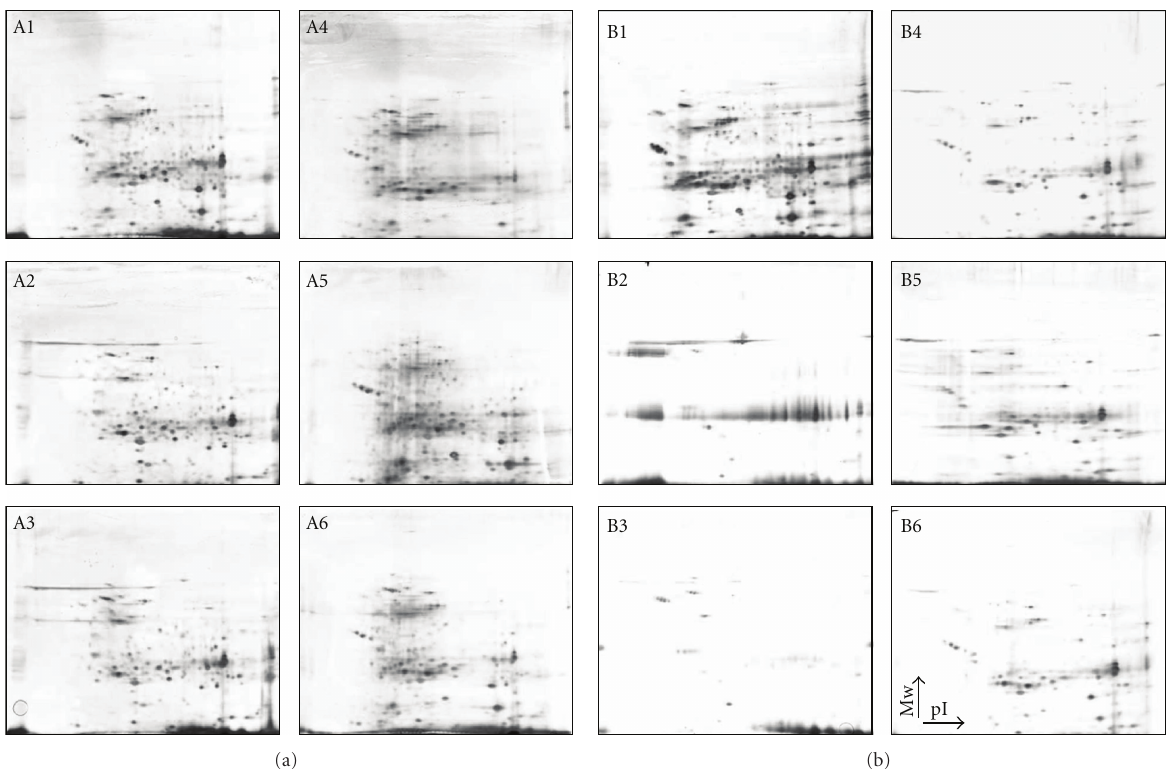
Figure 2: Two-dimensional separation of precipitated proteins (100 μ g) in PE placenta solubilized in (a) urea/CHAPS and (b) Hepes bu ff er. Precipitation procedures (1) dichloromethane/methanol, (2) TCA, (3) TCA followed by ethanol wash, (4) acetone, (5) acidified acetone, and (6) ethanol. The gels were stained with silver. Arrows on lower right image represent directions for increasing Mw and pI. Directions are the same for all